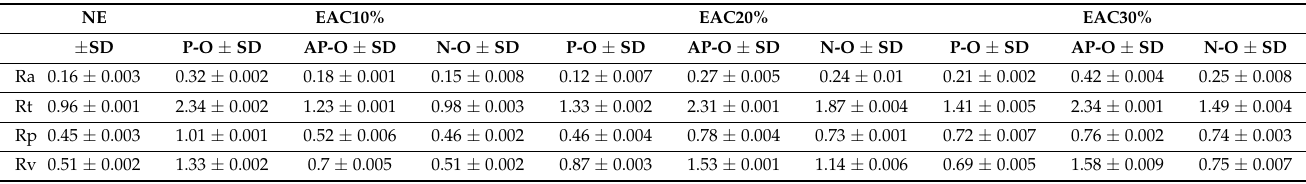
Table 2. Roughness parameters of tested materials in µm.